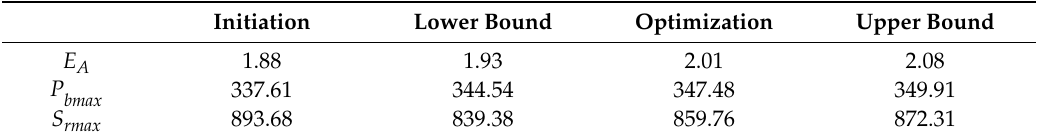
Figure 19. ( a ) Optimized value and intervals of propellant gas pressure at the breech, ( b ) optimized value and intervals of rifling stress and ( c ) optimized value and intervals of projectile kinetic energy. Table 7. Detailed optimization results and comparison of objective function and